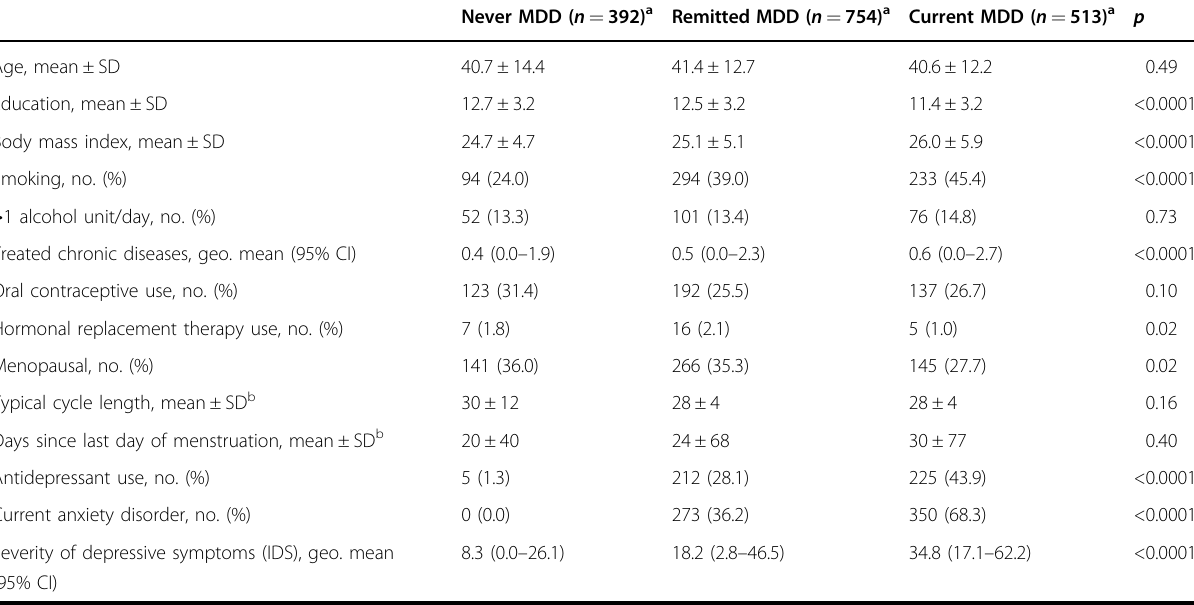
Table 1 Characteristics of 1659 women at